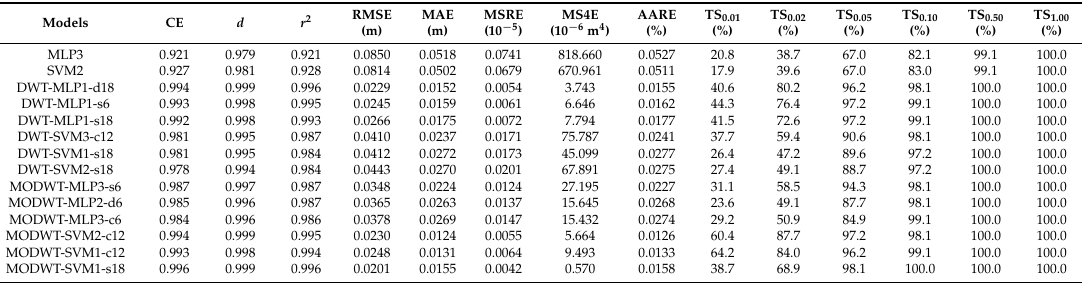
Table 5. Comparison of higher performance models for the high